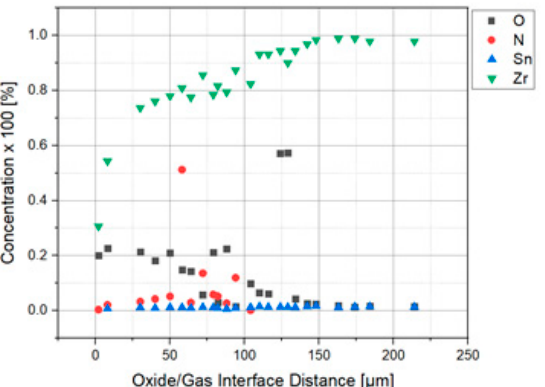
Figure 5. Evolution of the chemical composition on the isothermal oxidized sample section at 1050 °C for one hour. The determinations of microhardness in section, correlating with the oxygen content of the sample, highlighted the effects of dissolving the oxygen to stabilize an area with α phase and structural hardening (Figure 6).